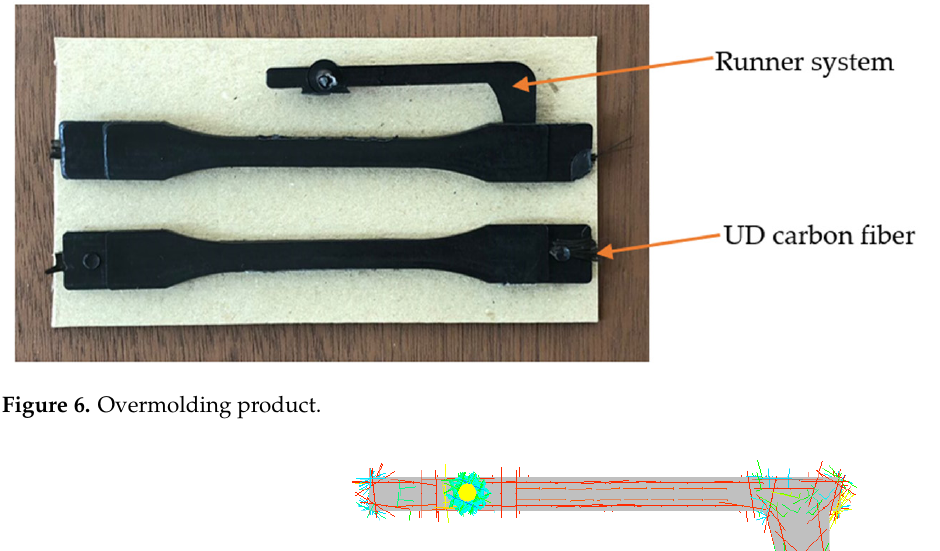
Figure 6. Overmolding product.